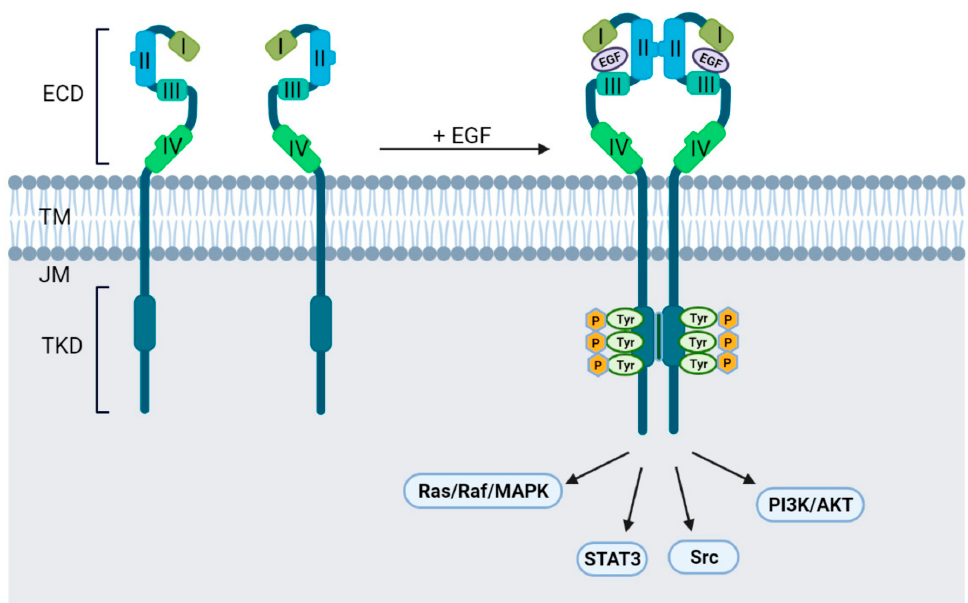
Figure 1. EGFR structure with relevant domains and signaling